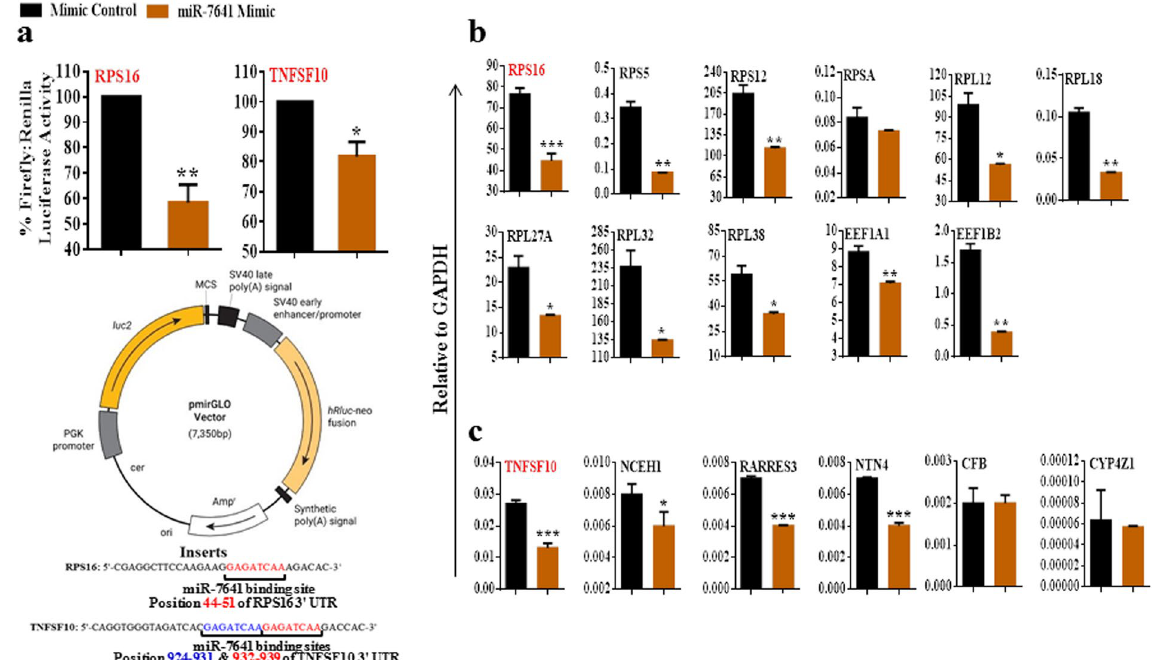
Figure 6. Luc gene activity assay confirmed RPS16 and TNFSF10 as target genes of miR-7641. ( a ) In both cases, bar diagrams showed that the ratio of firefly and renilla luciferase activity was significantly lower ( p < 0.01/ p < 0.05) in cells co-transfected with miR-7641 compared to the mimic negative control co-transfected cells. The pmiRGLO vector was used for the expression of miR-7641 target site, while the insert oligo sequence showing miR-7641 binding site in both RPS16 (44–51, of RPS16 3 ′ UTR) and TNFSF10 (924–931 & 932–939, of TNFSF10 3 ′ UTR) genes. ( b ) Bar diagrams showing the reduced expression of RPS16 and 10 other genes ( RPS5 , RPS12 , RPSA , RPL12 , RPL18 , RPL27A , RPL32 , RPL38 , EEF1A1 and EEF1B2 ) that are frequently co-expressed in breast cancer patients, in MCF-7 breast cancer cells upon transfection of miR-7641 compared to the mimic negative control transfected cells. ( c ) Bar diagrams presenting the expression of TNFSF10 along with five other genes ( NCEH1 , RARRES3 , NTN4 , CFB and CYP4Z1 ) that are frequently co-expressed in breast cancer patients, in miR-7641 transfected MCF-7 cells compared to the mimic negative control transfected cells. TNFSF10 , NCEH1 , RARRES3 and NTN4 were significantly reduced upon miR-7641 transfection, while CFB and CYP4Z1 showed no significant changes in expression. Bar diagrams show the mean ± SD obtained from triplicate experiments. * p < 0.05, ** p < 0.01, and *** p <